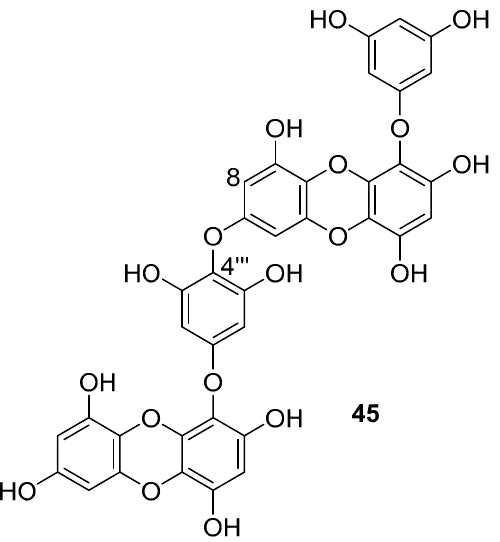
(cid:48)(cid:48)(cid:48) -dieckol ( 45 ) from E. cava